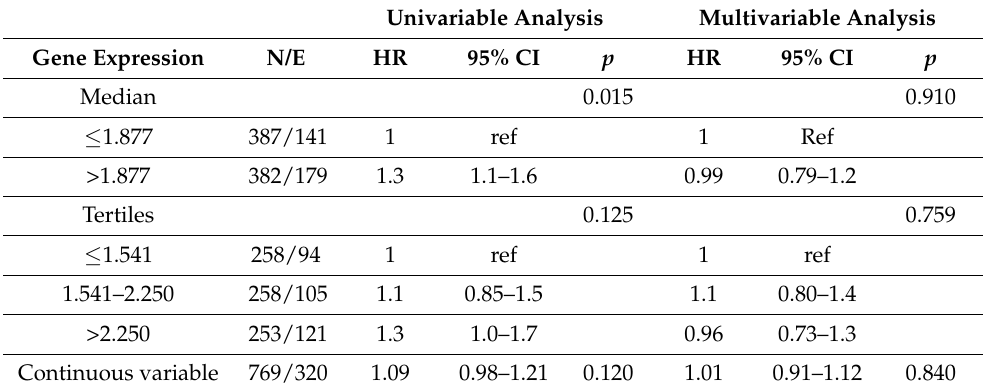
Table 11. Event Free Survival of 769 NB patients in relation to CMPK2 expression levels evaluated by the Cox model.